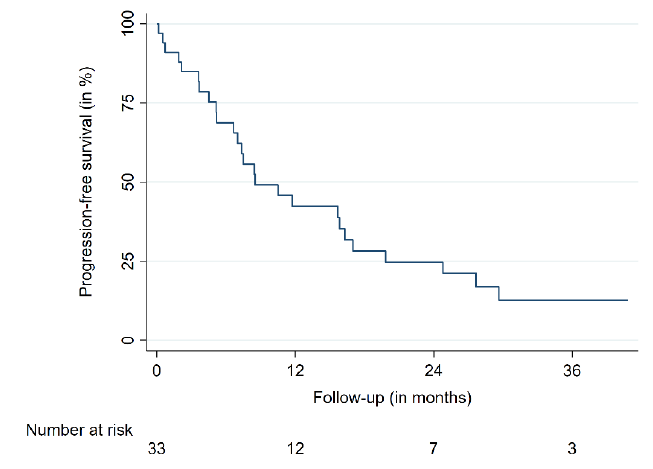
Figure 3. Progression-free survival.